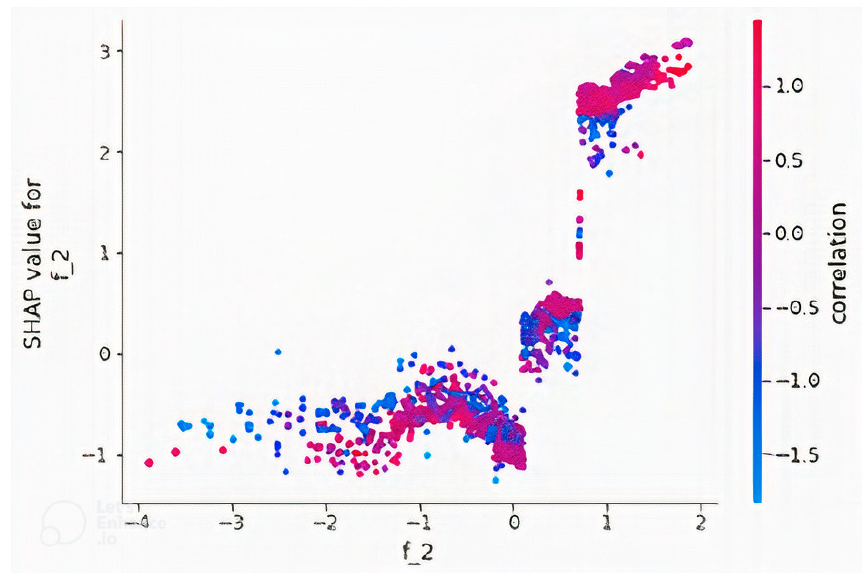
Figure 12. Dependence plot of the feature “f_2” in the model developed with a combination of non-image features and CNN + GLCM features. Feature ”f_2“ has the highest interaction index with the GLCM feature